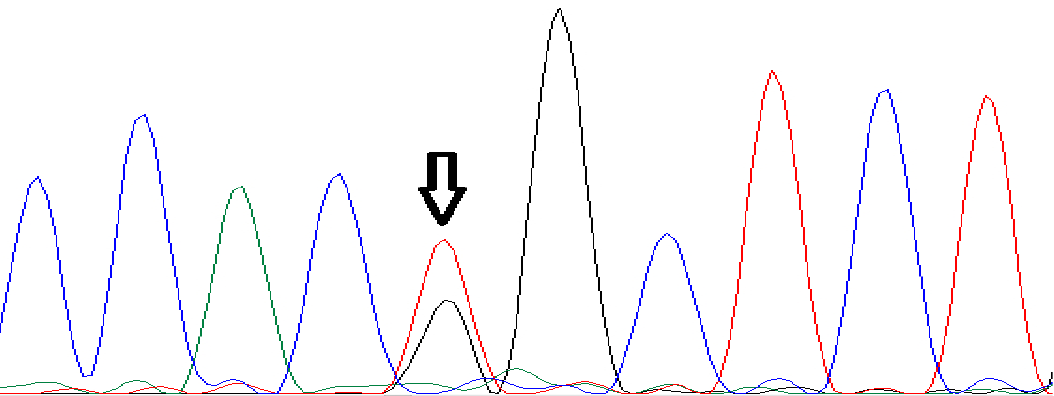
Figure 2. Sanger sequencing analysis of HbA1 gene in the case with Hb Mazandaran variant (c.154G > T).